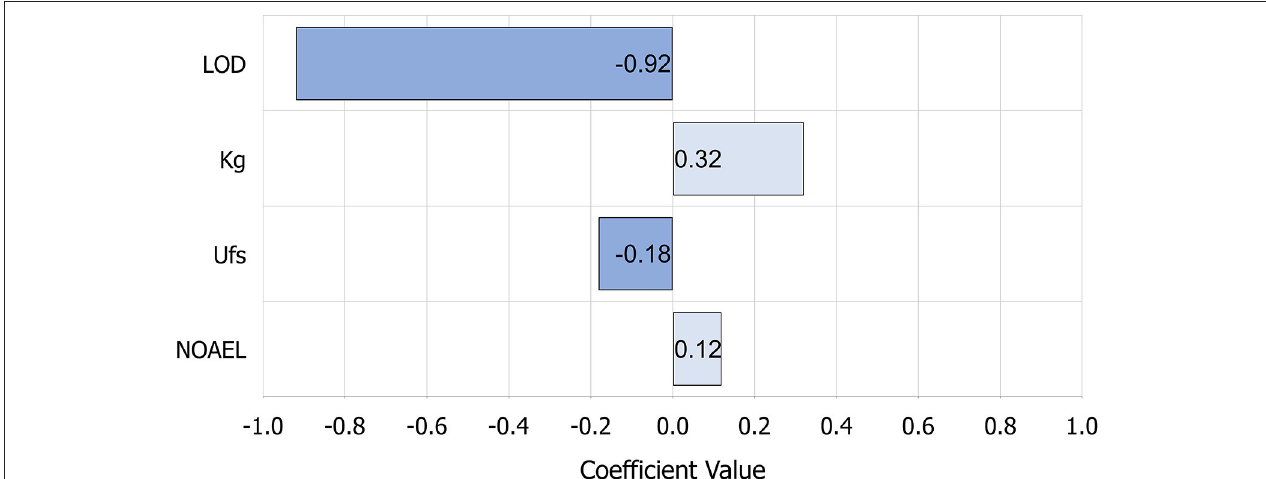
FIGURE 3 | Sensitivity analysis applying Spearman’s rank correlation coefficient of having adverse effects due to repeated dose of consumption of pheasant tissues with fenbendazole sulfone residues using pheasant LOD distribution. LOD is very strong negatively correlated; kilograms of body weight is moderate positively correlated; Ufs relationship is negligible; NOAEL relationship is negligible. Ufs, standard uncertainty factor; LOD, limit of detection; NOAEL, No-observed-adverse-effect level.